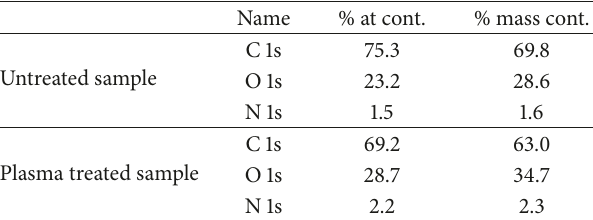
Table 2: The contents of elements on the surface from XPS for the untreated and plasma treated